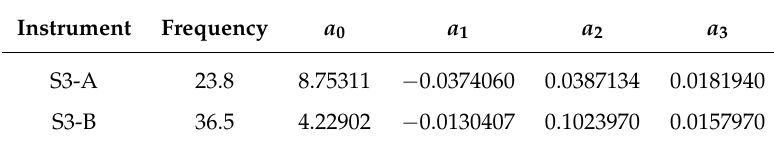
Table 2. Coefficients for Equation (2) (extracted from Bennartz et al. (2020) [14].)